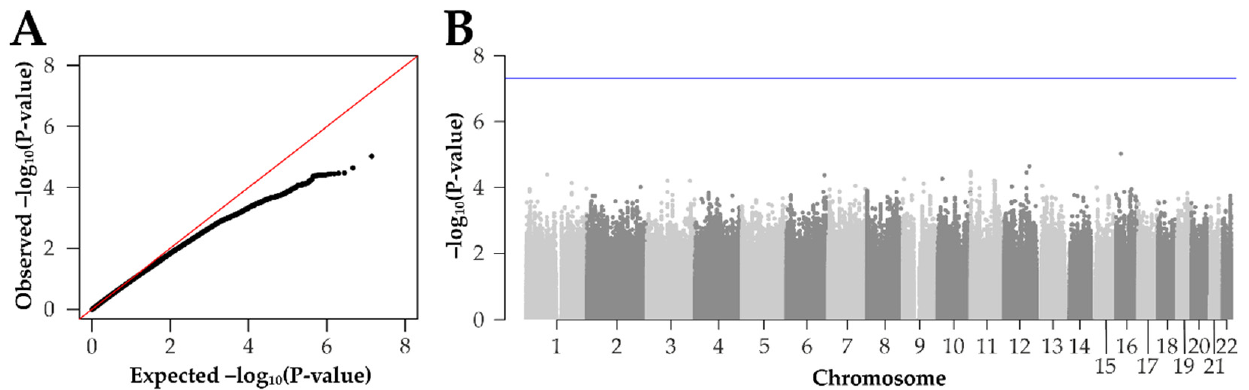
Figure 3. Genome-wide association study of anti-VEGF nAMD treatment response. We performed a logistic regression model to test the association of genetic variants with anti-VEGF nAMD treatment response. The study included 128 responders and 51 non-responders. ( A ) A quantile–quantile (QQ) plot of the results compares observed p -values with those expected under the null hypothesis of no association. ( B ) The Manhattan plot shows the -log 10 p -values and positions of 6,908,005 variants. The blue line indicates the threshold for genome-wide significance at 5 × 10 − 8 .